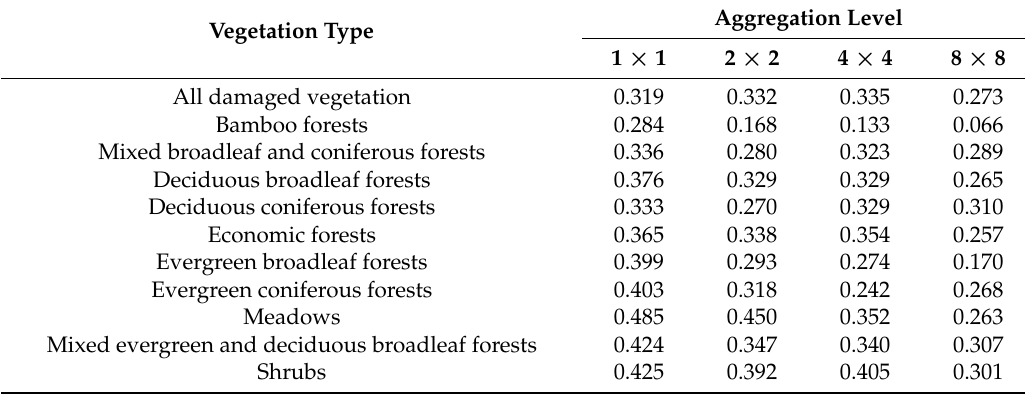
Table 6. Moran’s I of the residuals in the first lag at different aggregation levels.